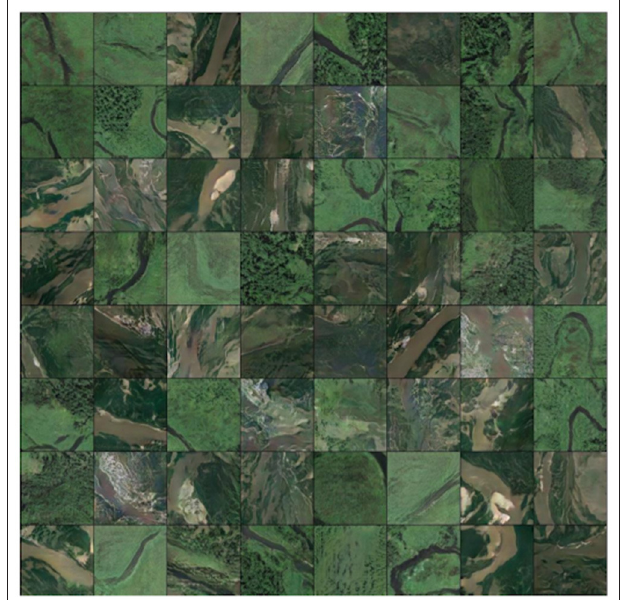
FIGURE 3 | Set of 64 GAN-generated satellite river imagery at 256 × 256 resolution.